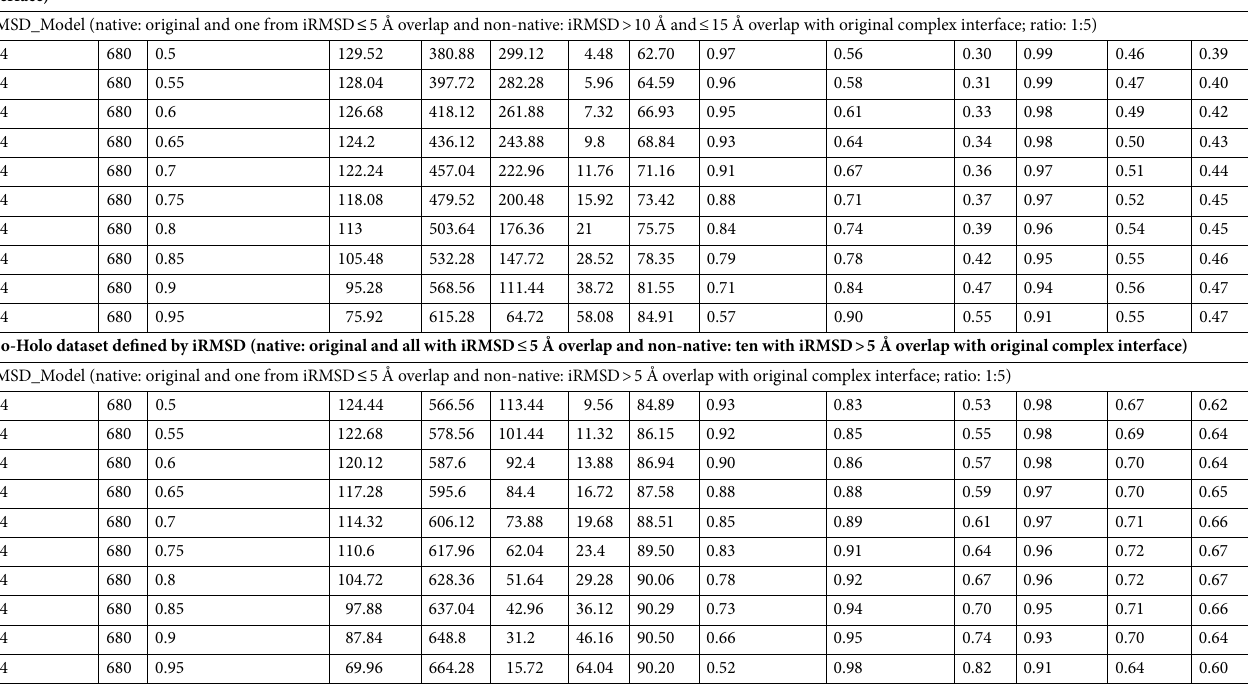
Table 2. Benchmarking results for Apo-Holo datasets using the Hetero FNAT and iRMSD